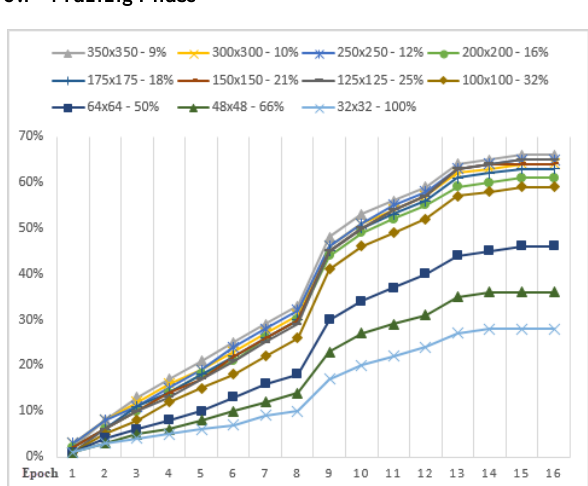
Figure 6. Evolution of the accuracy of the Resnet-18 training phase using various patche sizes of the KHATT dataset resized to 32x32